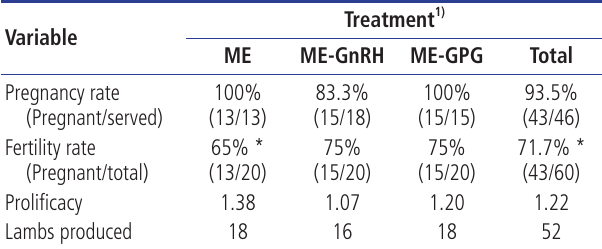
Table 4. Pregnancy rate, fertility rate, prolificacy, and number of lambs produced by anestrous Suffolk ewes exposed to different treatments in experiment 2